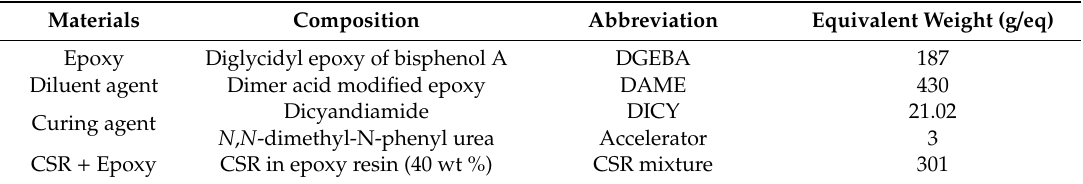
Table 1. Materials used for the epoxy adhesives.